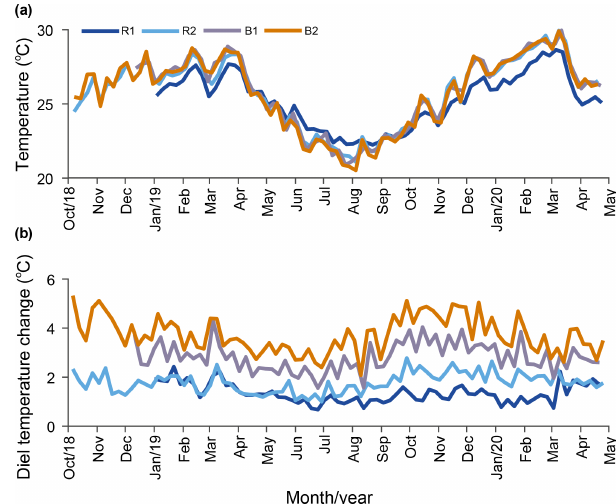
Figure 3. Long-term temperature monitoring from October 2018 to April 2020 at the reference (Sts R1 and R2) and Bouraké (Sts B1 and B2) reefs. Data are plotted using weekly averaged temperature (a) and weekly averaged diel (b) changes.